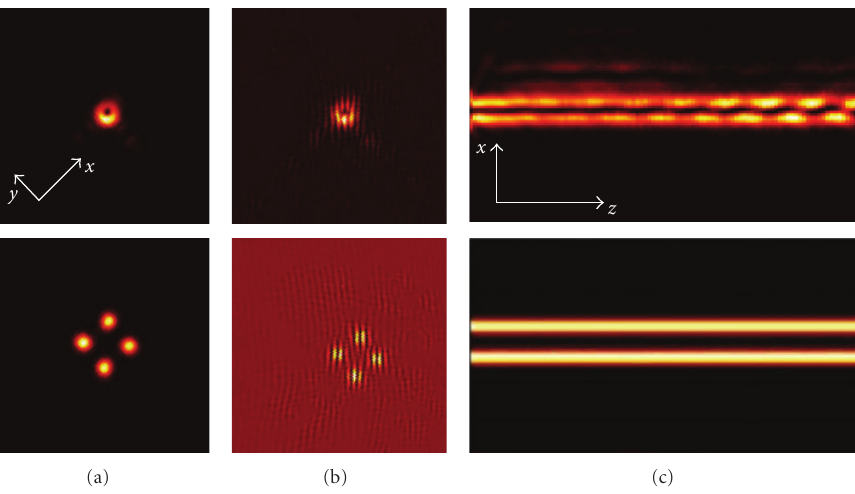
Figure 6: Numerical simulation of single-site (top) and four-site (bottom) surface excitation of a SCV after 4-cm of nonlinear propagation. Shown are (a) vortex output intensity pattern and (b) its corresponding interferogram, and (c) side-view of the vortex propagation to z = 4